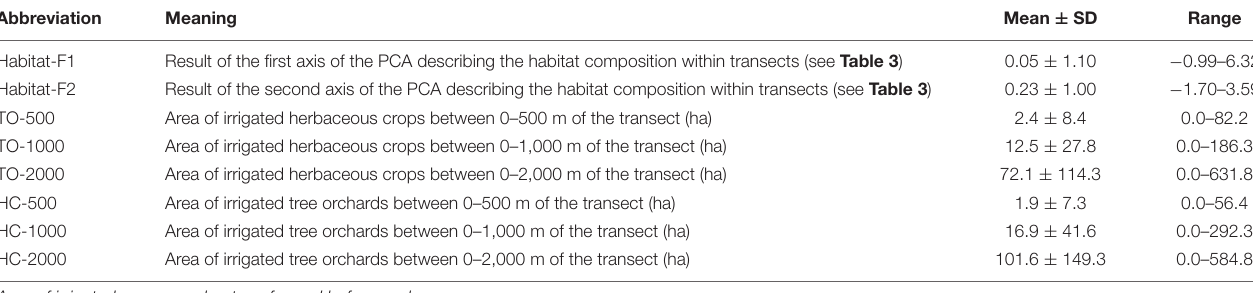
TABLE 1 | Habitat variables measured within and around each linear transect.